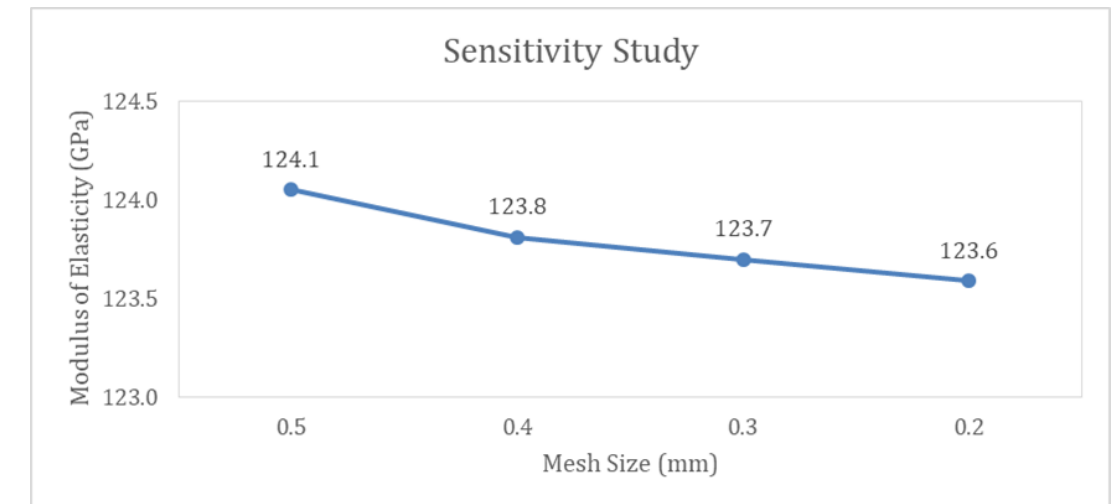
Figure 2. Sensitivity study to indicate the mesh size to which the modulus of elasticity converges using a solid cube.